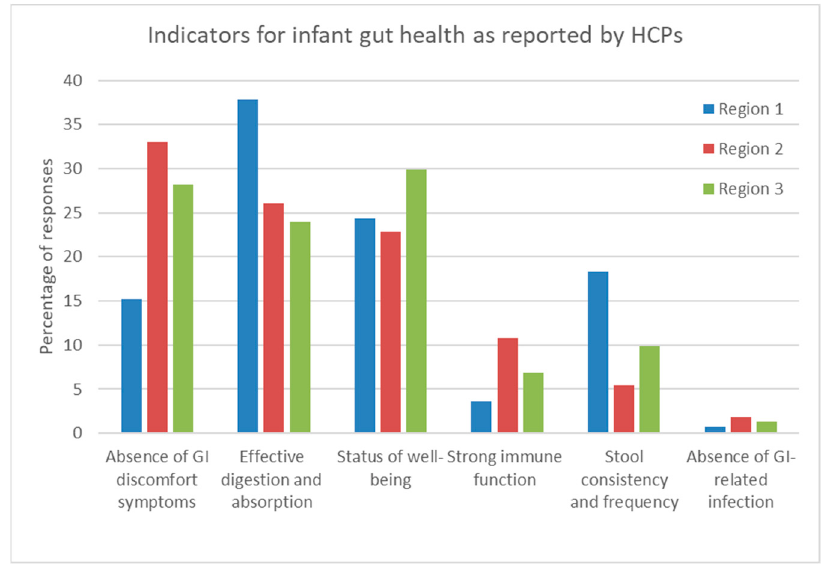
Figure 3. Percentages of responses by HCPs regarding their preferred indicators of infant gut health per region. Region 1 (Asia: consisting of Indonesia, Malaysia, and Hong Kong), Region 2 (Europe, consisting of Russia and Turkey), and Region 3 (Rest of the world, including KSA and Mexico).